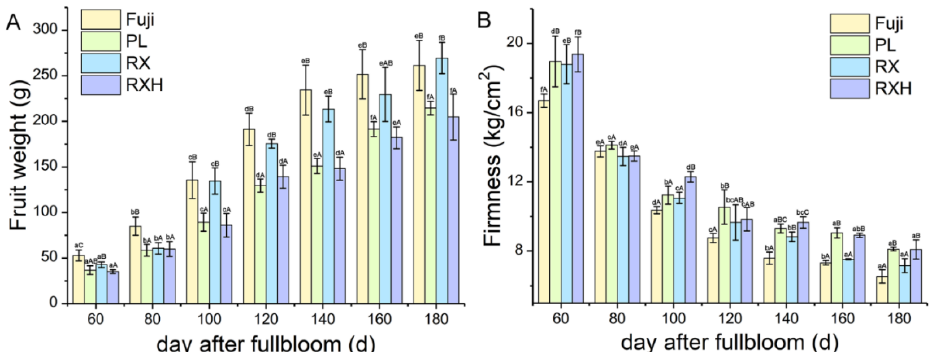
Figure 2. The variation of physiological characters in the ‘Ruixue’ and ‘Ruixianghong’ varieties and their parents apples during fruit development. ( A ) Fruit weight; ( B ) fruit firmness. Different lowercase letters in columns denote significant differences between sampling dates for each cultivar by Duncan’s multiple range test ( p < 0.05). Different capital letters in columns denote significant differences by Duncan’s multiple range test ( p < 0.05) among different cultivars. Different colors represent different cultivars.